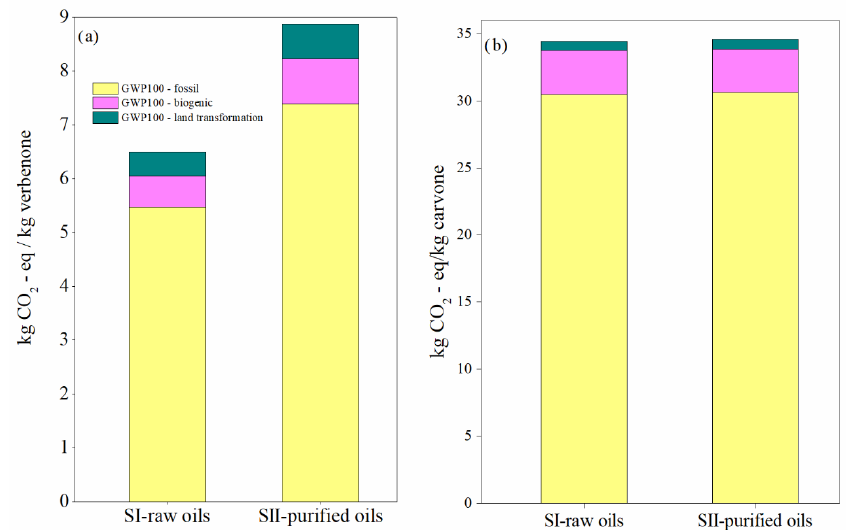
Molecules 2022 , 26 , x FOR PEER REVIEW 16 of 21 Figure 12. Global warming potential in the SI-raw-oils and SII-purified-oils scenarios for the ( a ) verbenone and ( b ) the carvone process production. Assessment method: IPCC 2021 GWP100 v1.0. An uncertainty analysis of the environmental impacts of the different scenarios of the process is shown in Figure 13. The single score probability results of the environmental impacts to produce 1 kg/batch of carvone were higher than the probabilities in the pro- duction of verbenone. However, the differences between the statistical parameters re- ported in Table 3 were very similar for the production of carvone since the orange essen- tial oil has high levels of d -limonene concentration and the results do not affect both sce- narios evaluated, as presented in Figures 9b and 12b.